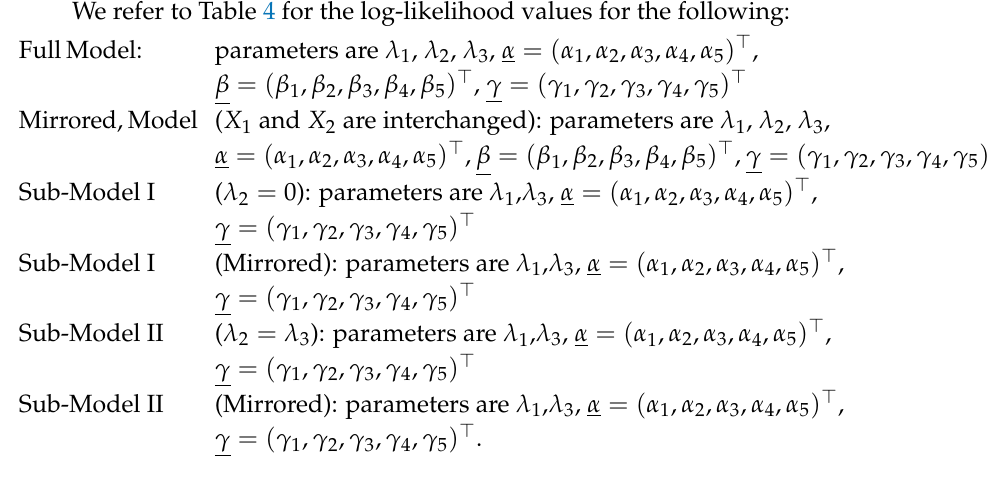
Table 4. Models for the Road safety